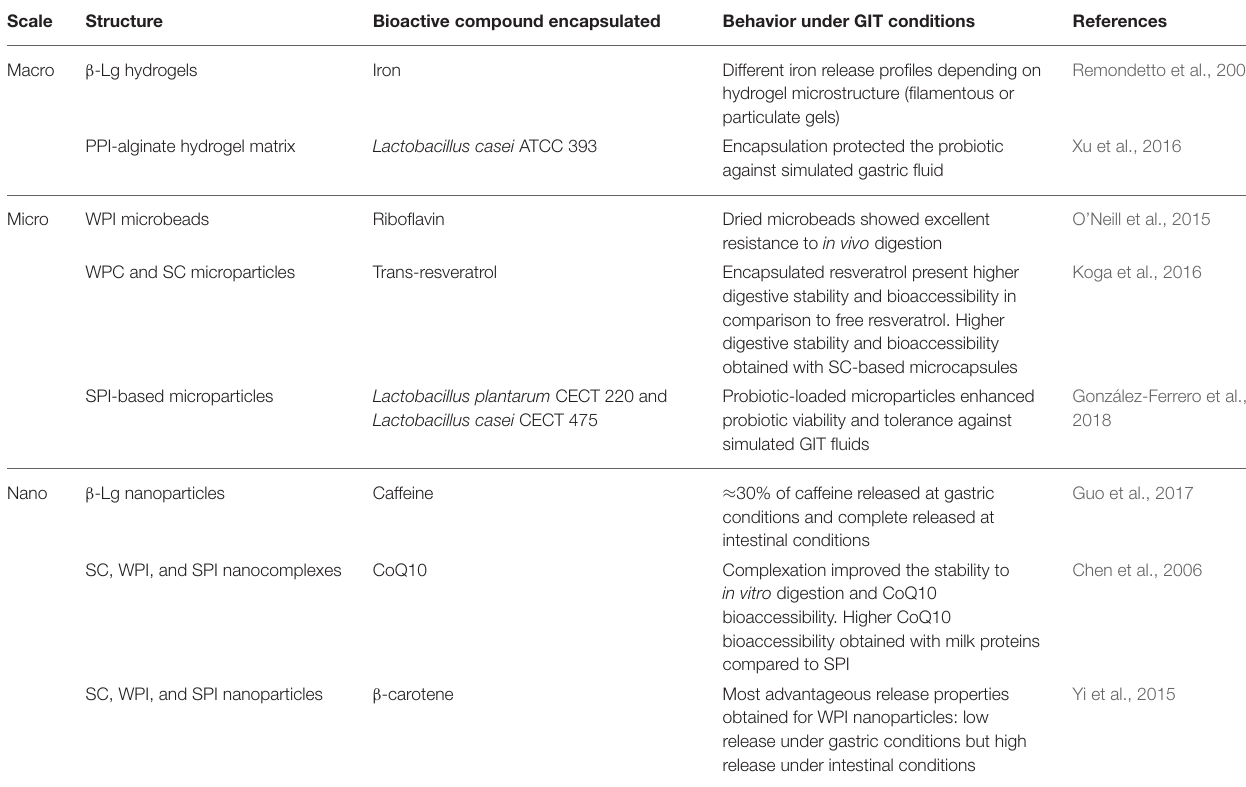
TABLE 3 | Selected examples of protein-based structures under GIT